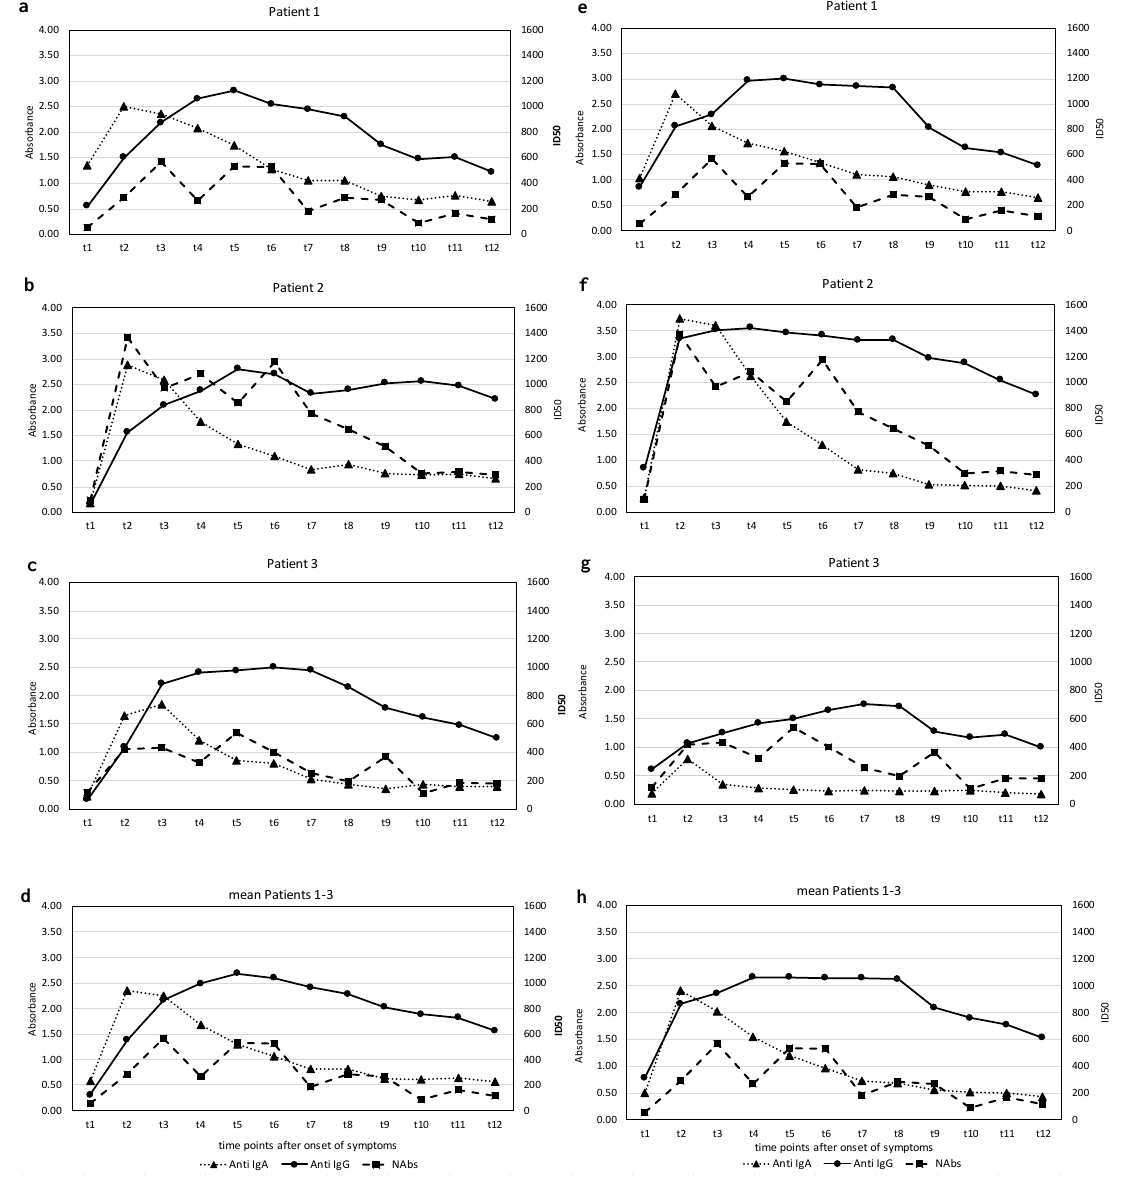
Figure 2. ( a – h ): Serum antibodies to SARS-CoV-2 S-protein (IgA; IgG) and serum virus neutralizing activity (NAbs) in individual patients over time ( a – c ). Averaged levels of the three patients are illustrated in d—serum antibodies to SARS-CoV-2 N-protein (IgA; IgG) and serum virus neutralizing activity (NAbs) in individual patients over time ( e – g ). Averaged levels of the three patients are illustrated in h.